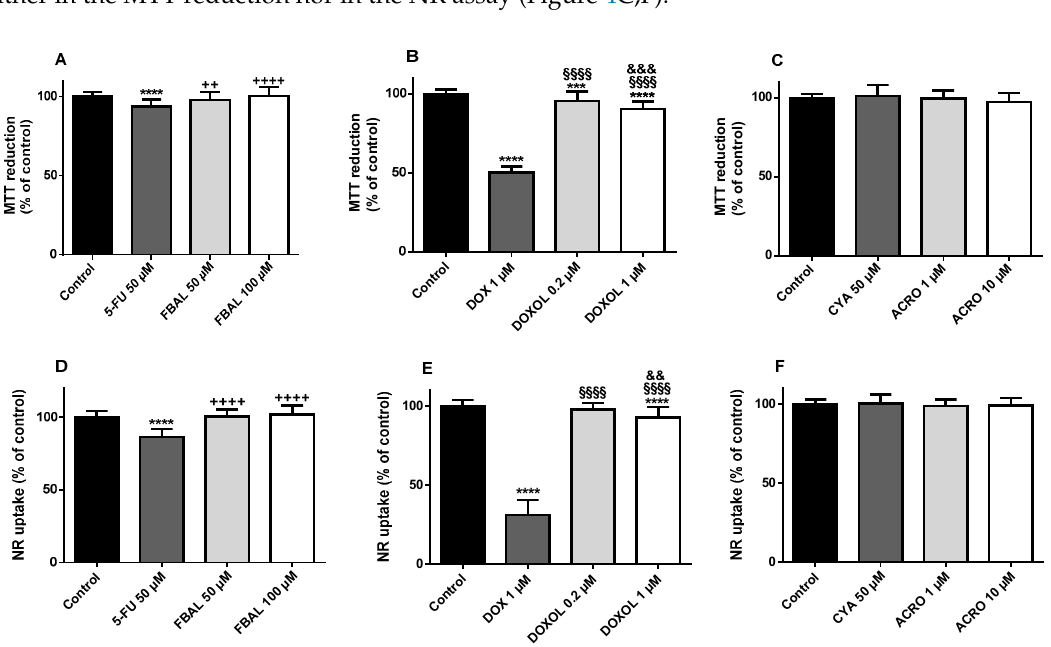
Figure 4. Cytotoxicity evaluated by ( A–C ) the 3-(4,5-dimethylthiazol-2-yl)-2,5-diphenyl tetrazolium bromide (MTT) reduction assay and ( D – F ) the neutral red (NR) uptake assay in differentiated H9c2 cells incubated for 48 h with 5-fluorouracil (5-FU) 50 µ M and α -fluoro- β -alanine (FBAL) 50 µ M and 100 µ M ( A , D ); doxorubicin (DOX) 1 µ M, and doxorubicinol (DOXOL) 0.2 µ M and 1 µ M ( B , E ); and cyclophosphamide (CYA) 50 µ M, and acrolein (ACRO) 1 µ M and 10 µ M ( C , F ). Results are presented as mean ± SD of three to five independent experiments (total of 20–34 wells). Statistical analyses were performed using the Kruskal–Wallis test, followed by the Dunn ′ s post hoc test ( A ) or the analysis of variance (ANOVA) test, followed by the Tukey post hoc test (B – F ) (*** p < 0.001, **** p < 0.0001 vs. control; ++ p < 0.01, ++++ p < 0.0001 vs. 5-FU 50 μ M; §§§ p < 0.001, §§§§ p < 0.0001 vs. DOX 1 μ M; && p < 0.01, &&& p < 0.001 vs. DOXOL 0.2 μ M).